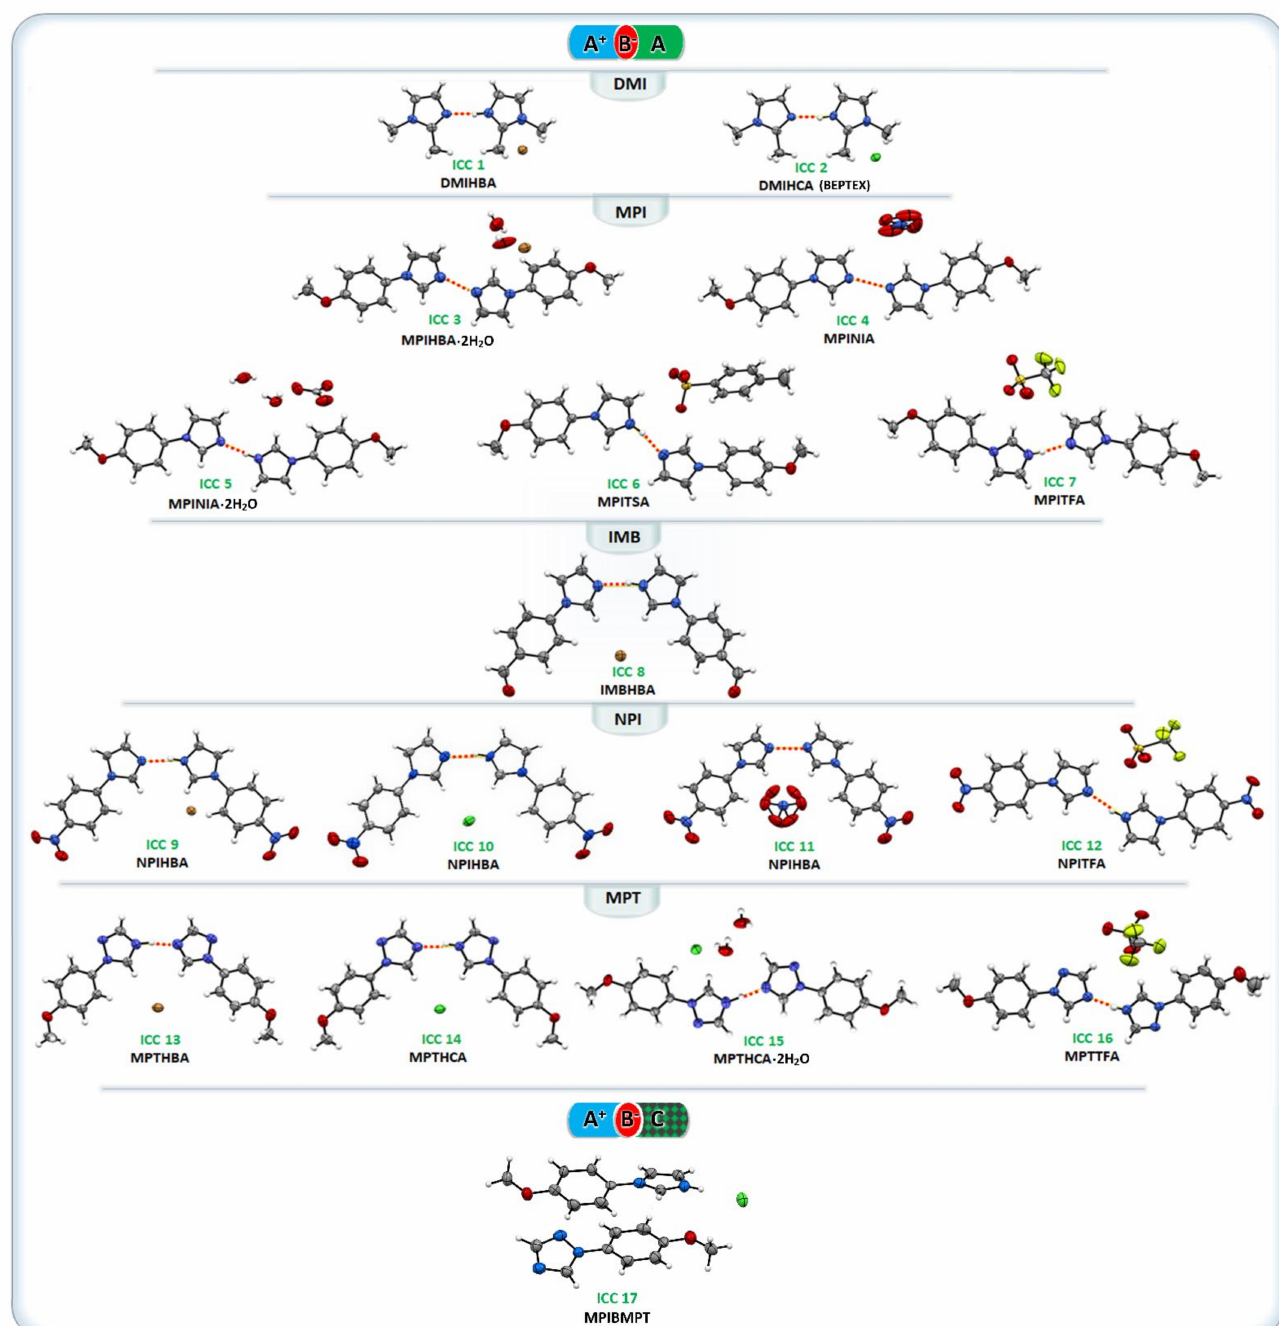
Figure 1. ORTEP diagrams of A + B − A ICCs 1–16 and A + B − C ICC 17 (50%